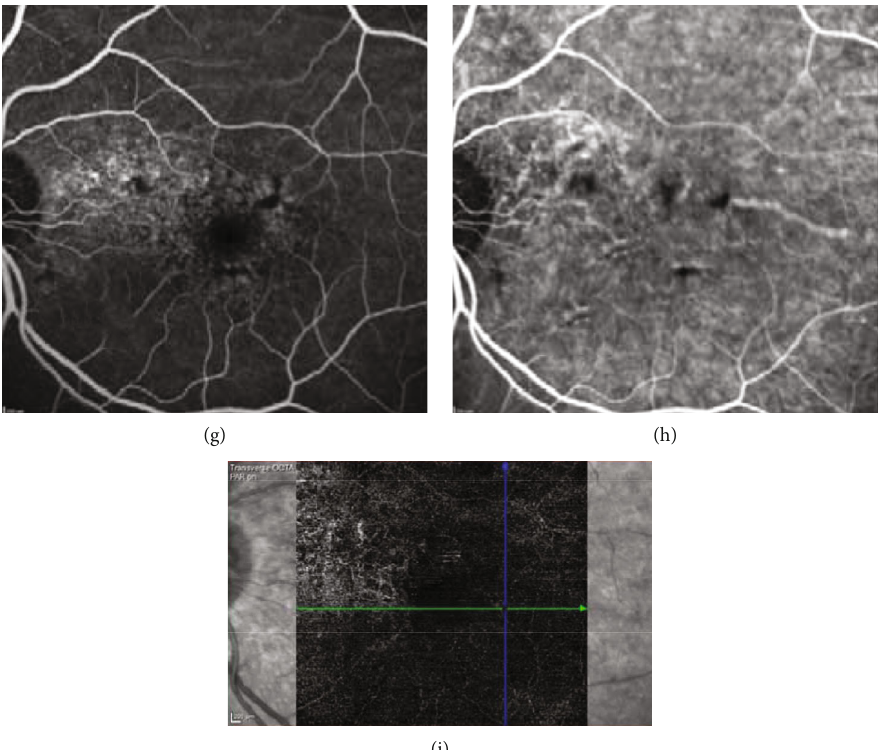
Figure 3: (a) – (h) Early and late phase combined fundus fl uorescein angiography (FFA) and indocyanine green angiography (ICGA) showing window defects and blocked fl uorescence corresponding to vitelliform deposits with no evidence of neovascularization network. Note the abnormal network evident on OCTA (i) in the left eye suggestive of nonexudative choroidal neovascular membrane (CNVM).